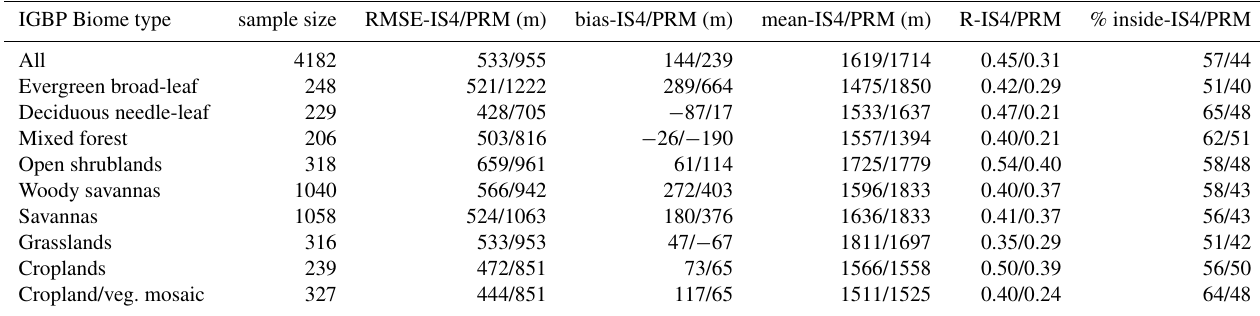
Figure 7. Density plots of global comparison of the MPHP2 observations of plume height in 2008 against the IS4FIRES (left) and the PRM (right) injection heights of GFAS. MPHP2 observations with “good” and “fair” quality flags were used. The dashed lines delineate the area in which the GFAS injection heights are within 500m of observations. Table 3. Scores of IS4FIRES/PRM plume height against the MPHP2 data set for the year 2008, for each IGBP biome type. The “% inside” score corresponds to the relative fraction of estimated plumes that are within 500m of the MPHP2 observations. IGBP Biome type sample size RMSE-IS4/PRM